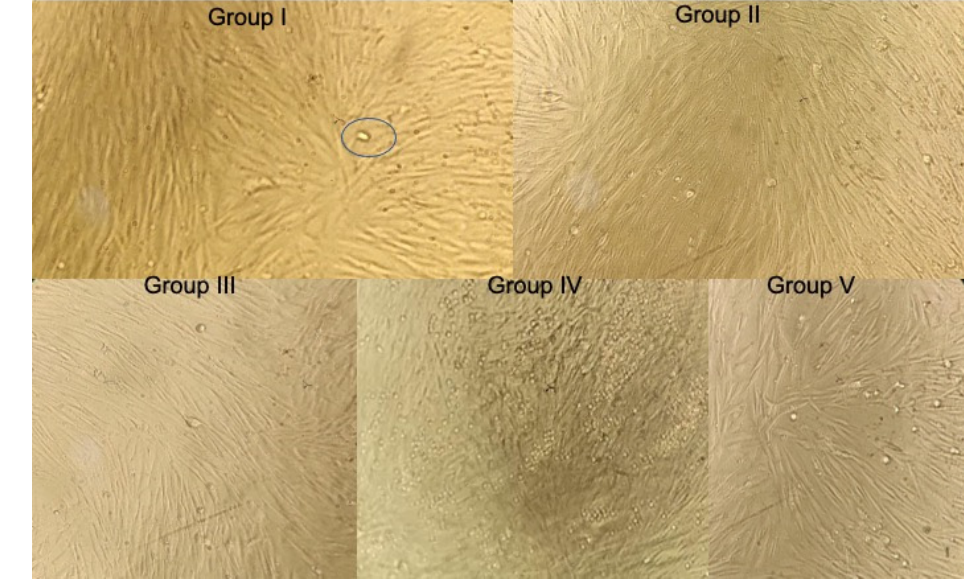
Figure 2. Histological assessment of MTT Assay of hDPSCs treated with groups after 48 h. Circle represents living stem cells in cluster form.